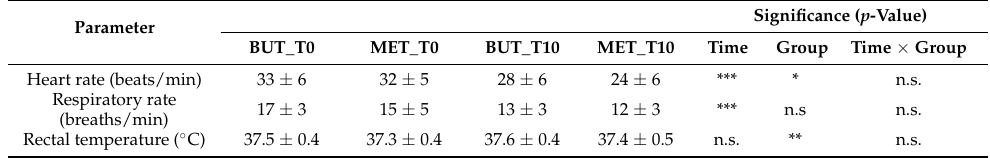
Significance ( p -Value)